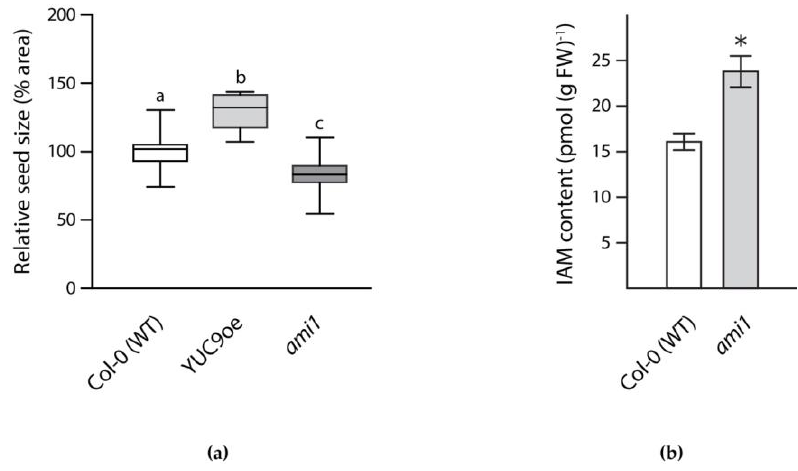
Figure 4. Analysis of auxin mutants. ( a ) Seed size of two selected mutants relative to wild-type Arabidopsis seeds. Box plot showing the relative seed size of wild-type (white box), YUC9oe (light grey box), and ami1 (dark grey box) seeds. The values display the median, quartiles and extremes of the compared data sets, n = 16. Different letters indicate significant differences in seed size analyzed by ANOVA and Tukey’s B post-hoc test, p < 0.01; ( b ) Quantification of IAM levels in wild-type Arabidopsis and the ami1 T-DNA insertion line. Two-week-old seedlings were used for the determination of IAM by LC-MS analysis. Three independent biological replicates were assessed. Given is the standard error of the mean, n = 9 (Student’s t -test; * p < 0.05).